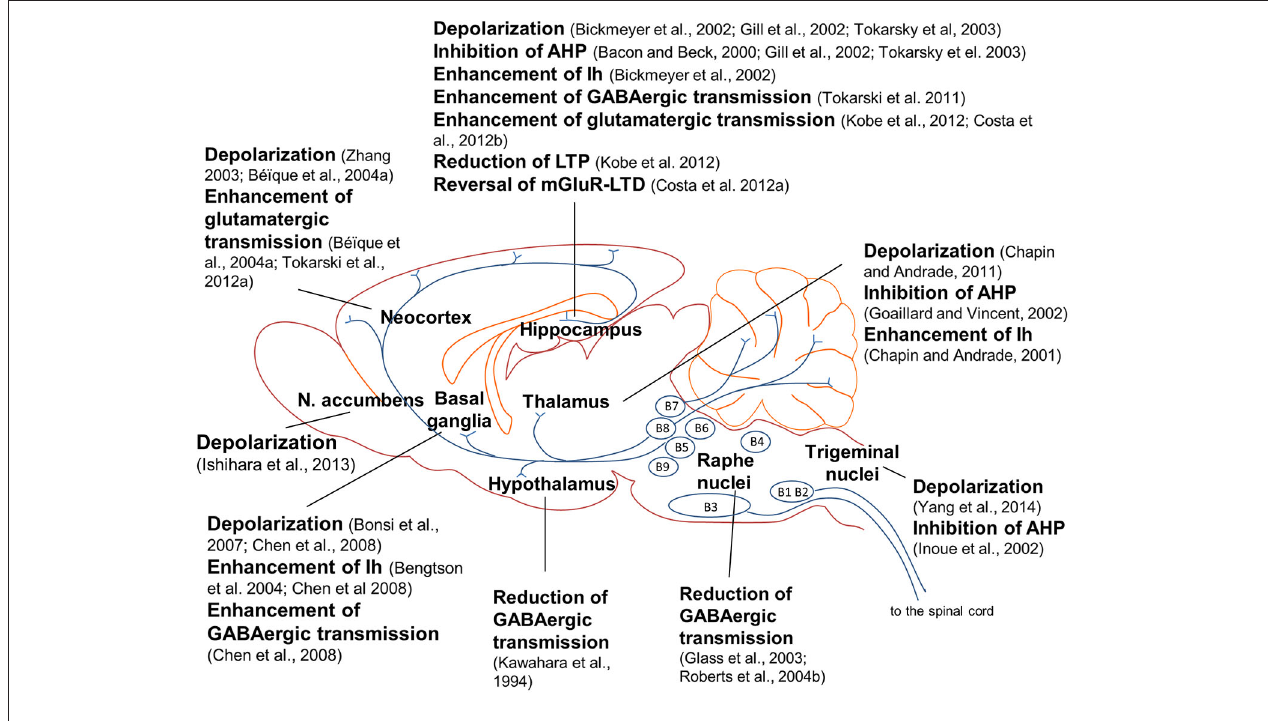
and hippocampus. 5-HT 7 receptors differently modulated GABAergic synaptic transmission in distinct brain areas; notably, activation of 5-HT 7 receptors in raphe nuclei inhibited GABAergic interneurons, enhancing the activity of serotonergic raphe neurons and 5-HT release in target structures. Most of the results illustrated here were obtained in the rat, with the following exceptions: mouse (Bickmeyer et al., 2002; Costa et al., 2012a; Yang et al., 2014), hamster (Glass et al., 2003) and guinea pig (Roberts et al.,